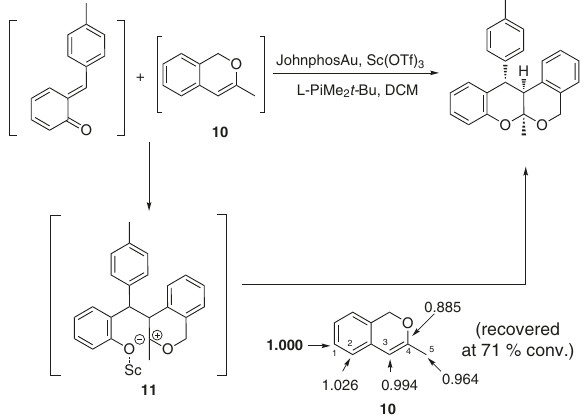
Fig. 6 Carbon isotope effects (R/R 0 ) calculated for 3a. The carbon valued in bold was taken as the internal